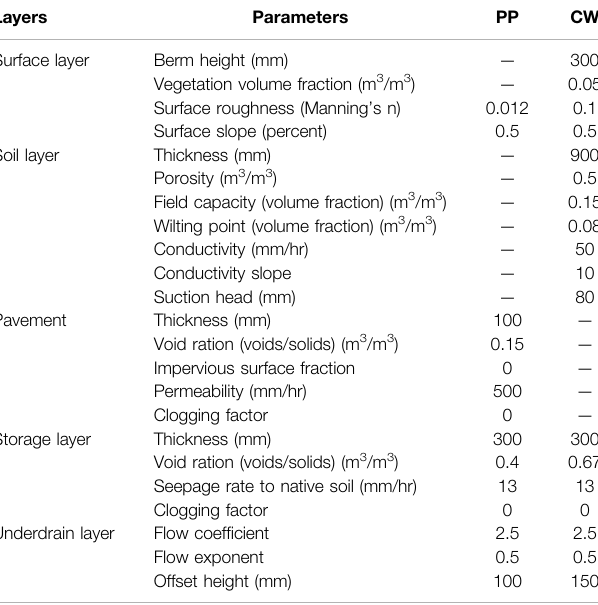
Note: sources from Rossman and Huber